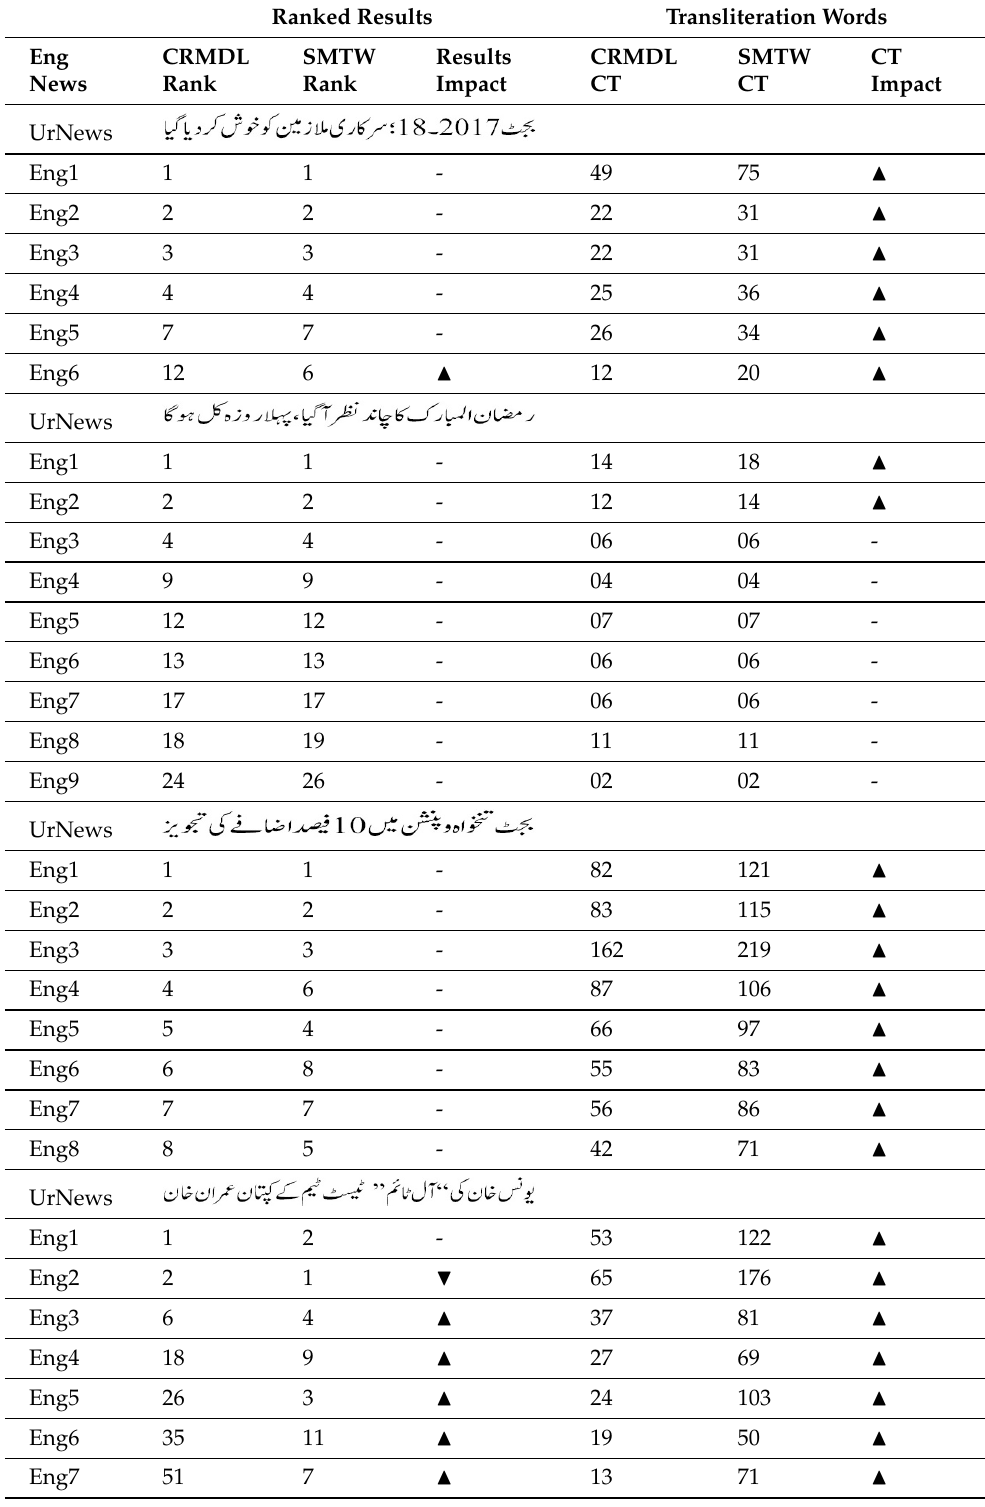
Table 10. Results improvement by SMTW approach for one-day news article set, (cid:72) shows results impact is negative or dropped, (cid:78) shows results are improved and “-” represents “No Change or No